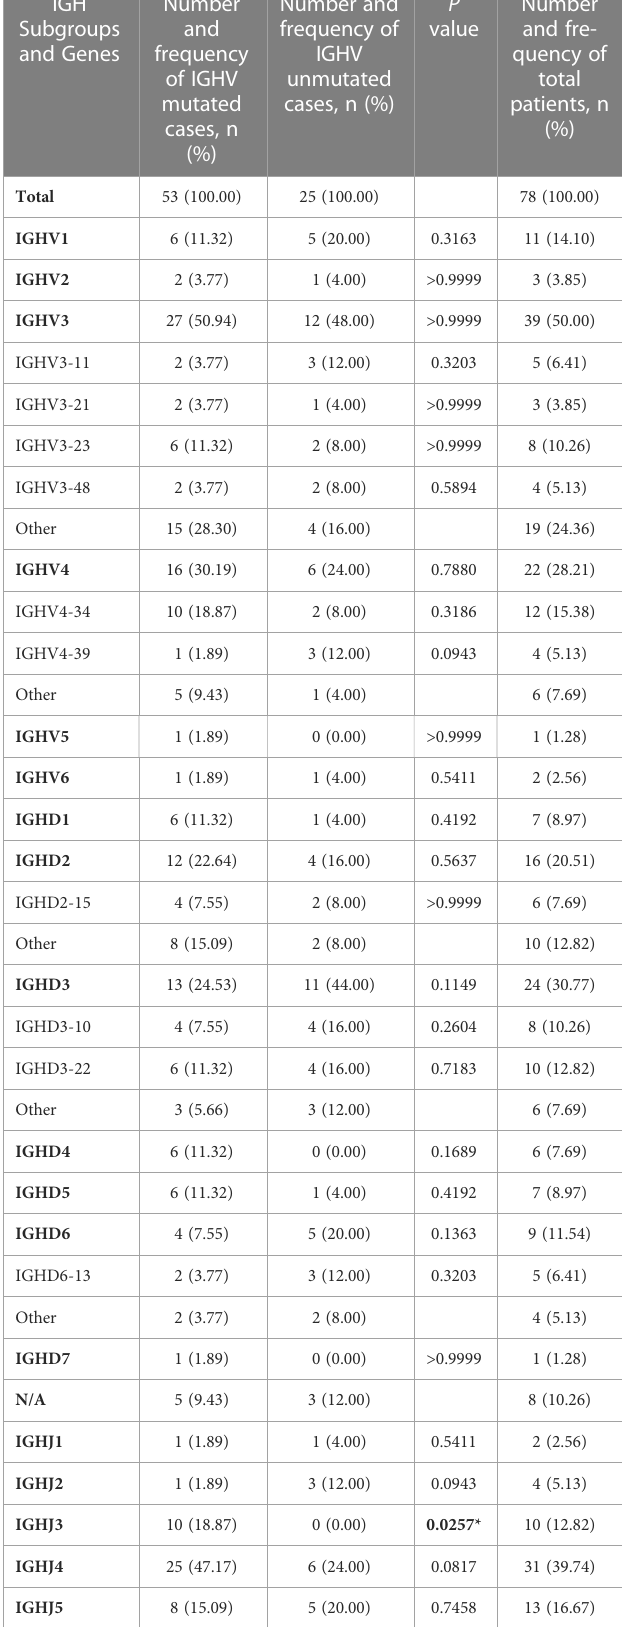
TABLE 2 IGHV, IGHD subgroups, and IGHJ genes used in CLL patients in our study. IGH Subgroups and